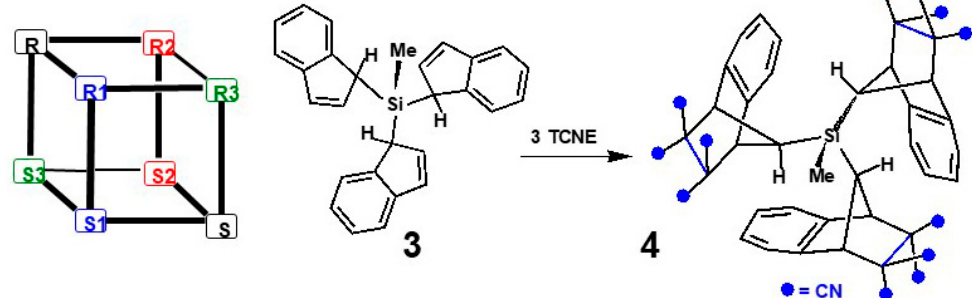
Figure 3. ( Left ) The cube representing exchange between eight di ff erent indenyl environments in 3 , and ( right ) the product of triple Diels-Alder addition of TCNE to tris(indenyl)methylsilane, 4 .